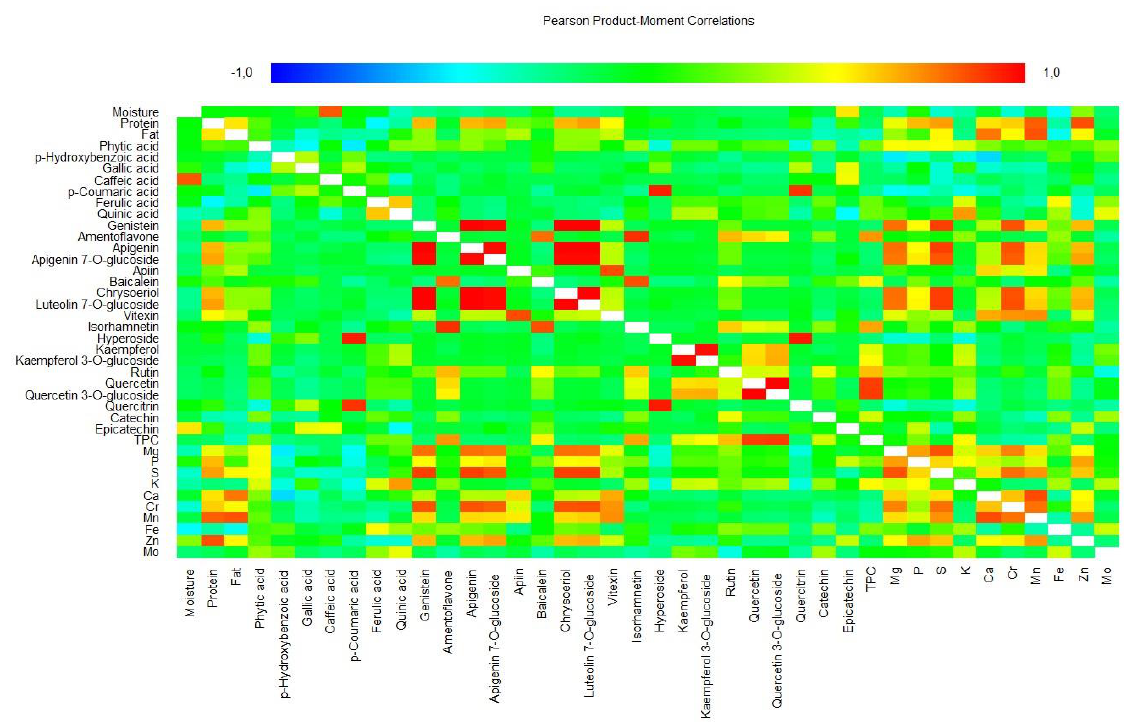
Figure 4. Pearson’s correlation matrix for 40 variables studied in pulse samples. TPC, total phenolic compounds.